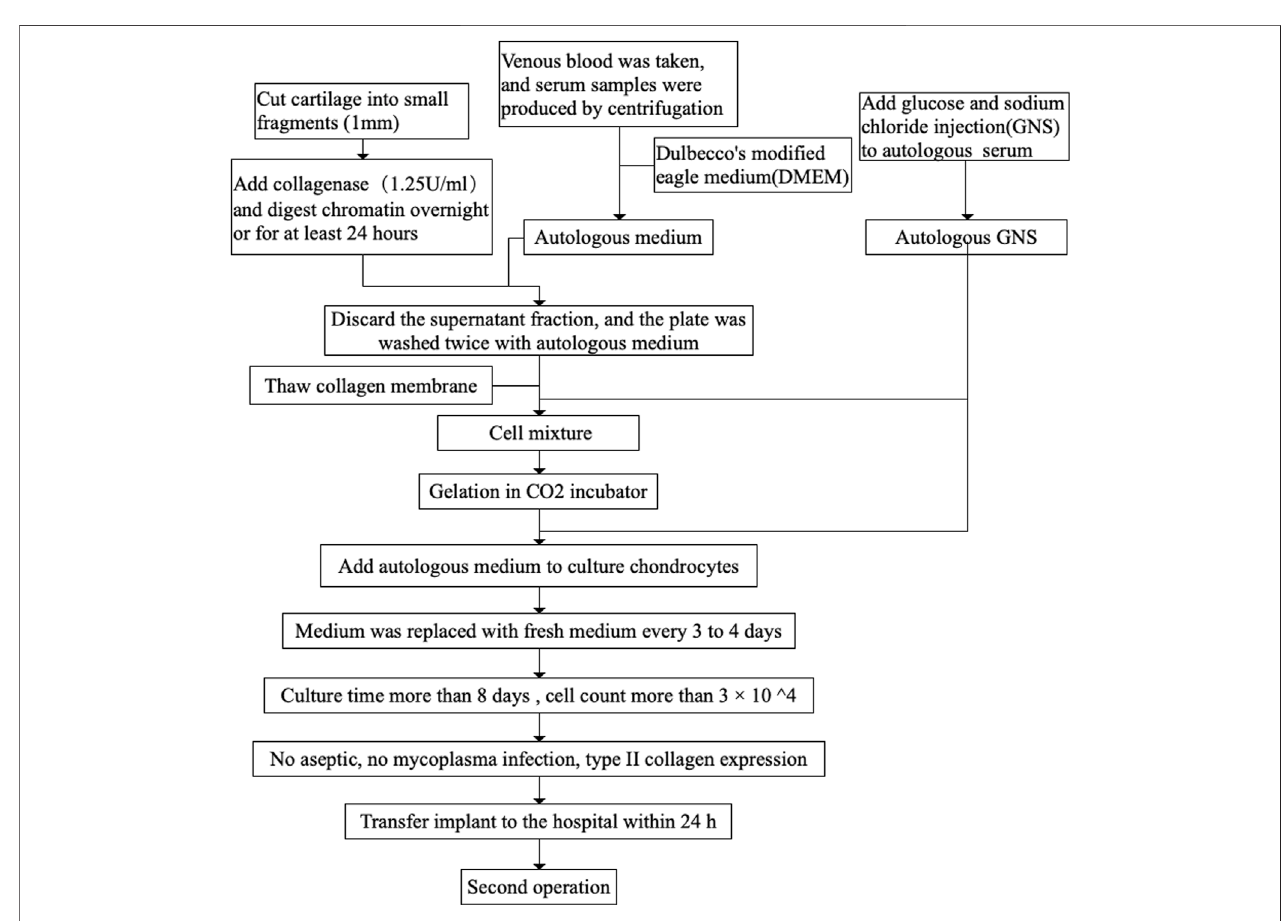
FIGURE 1 | A schematic about implant for preparation. DMEM, dulbecco ’ s modi fi ed eagle medium; GNS, glucose and sodium chloride injection.